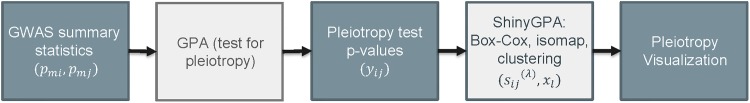
Summary of work flow for the ShinyGPA visualization approach.